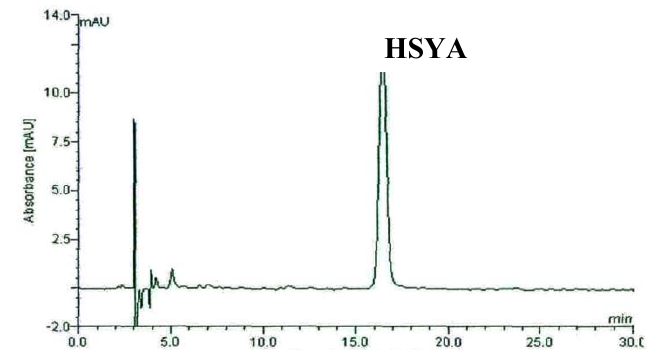
Figure 3. HPLC chromatograph of the separated HSYA. Conditions: same as Figure